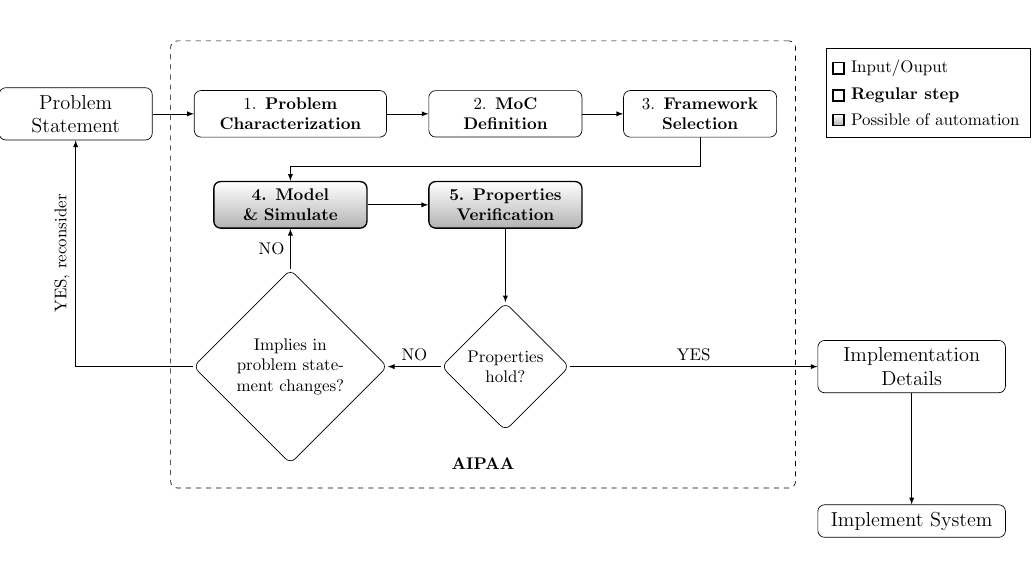
Figure 2. Analysis and identification of possible automation approaches (AIPAA) applicable to embedded systems design flow. AIPAA needs the “problem statement” as a given input, and aids to produce a model, which is verified and executable, as output. This output can be used as entry point in the implementation domain, e.g., “implementation details” and “implement